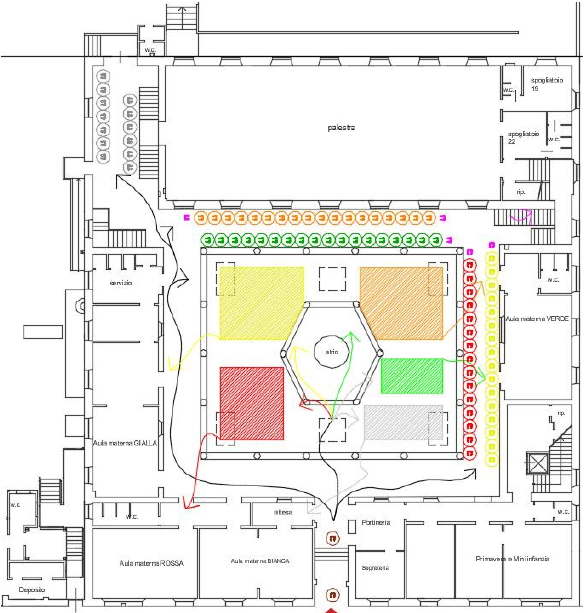
Figure 6. Proximity map. Low density identified by the blue colour, high density indicated by the red colour. Figure 7. Spatial configuration of the